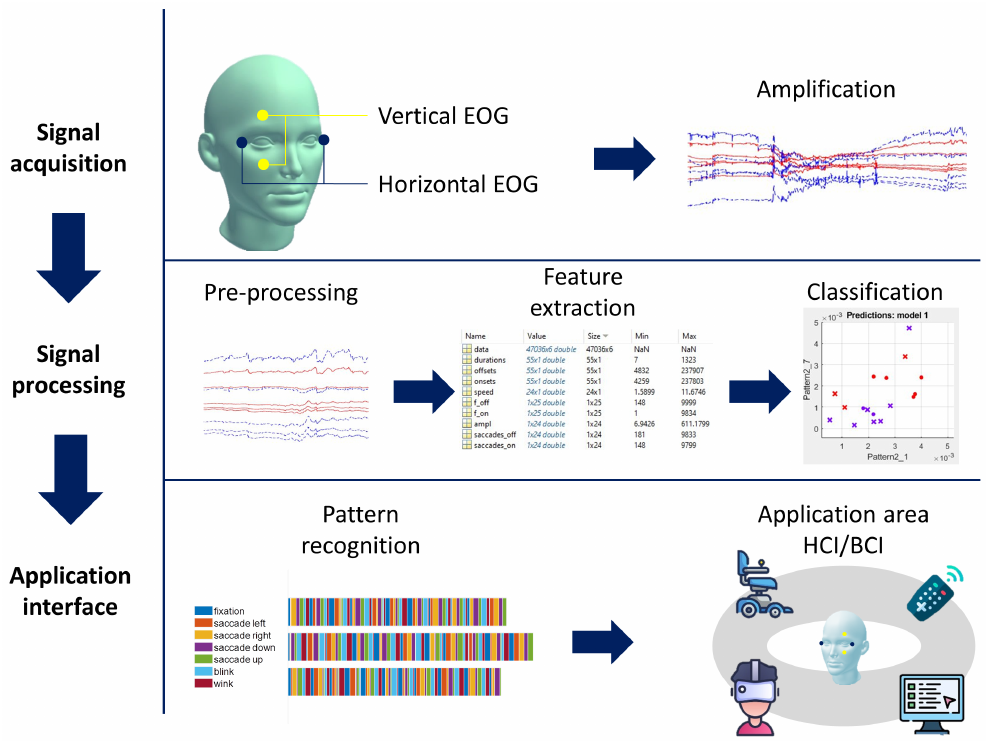
Figure 1. General scheme of an EOG-based BCI. First step, EOG acquisition: EOG is recorded using vertical and horizontal electrodes by an amplified ADC. Second step, Signal processing: after pre-processing, computer processing extracts the most relevant features for identifying the subject’s intentions. Third step, Application area: When the command is recognized and the intention is classified, the instruction is sent to an external device (e.g., web browser, wheelchair, or text display). Feedback informs the user of the results of their actions to allow them to prepare for the next